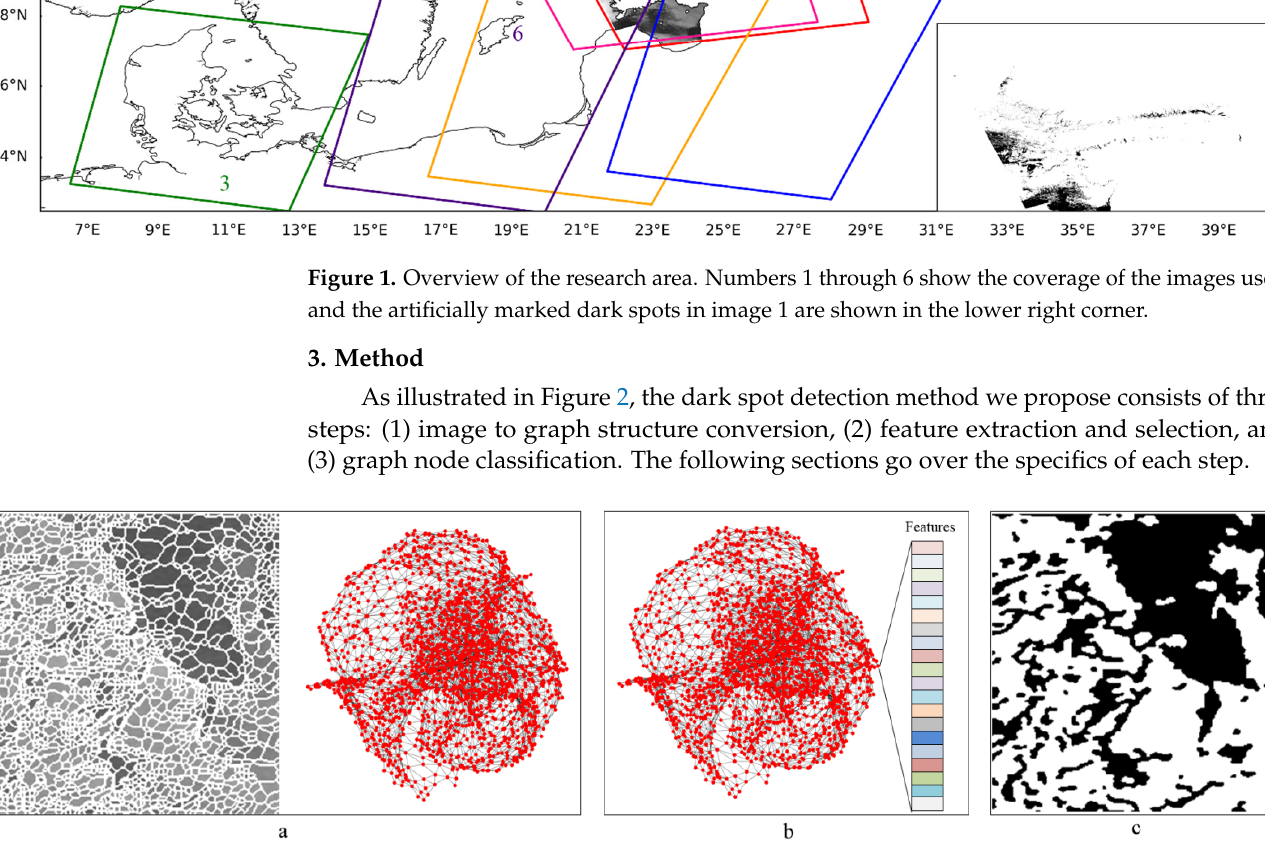
Figure 2. Workflow of the proposed dark spot segmentation method. ( a ) depicts the process of transforming the image into a graph structure, ( b ) depicts feature extraction and selection, and ( c ) depicts final graph node classification.